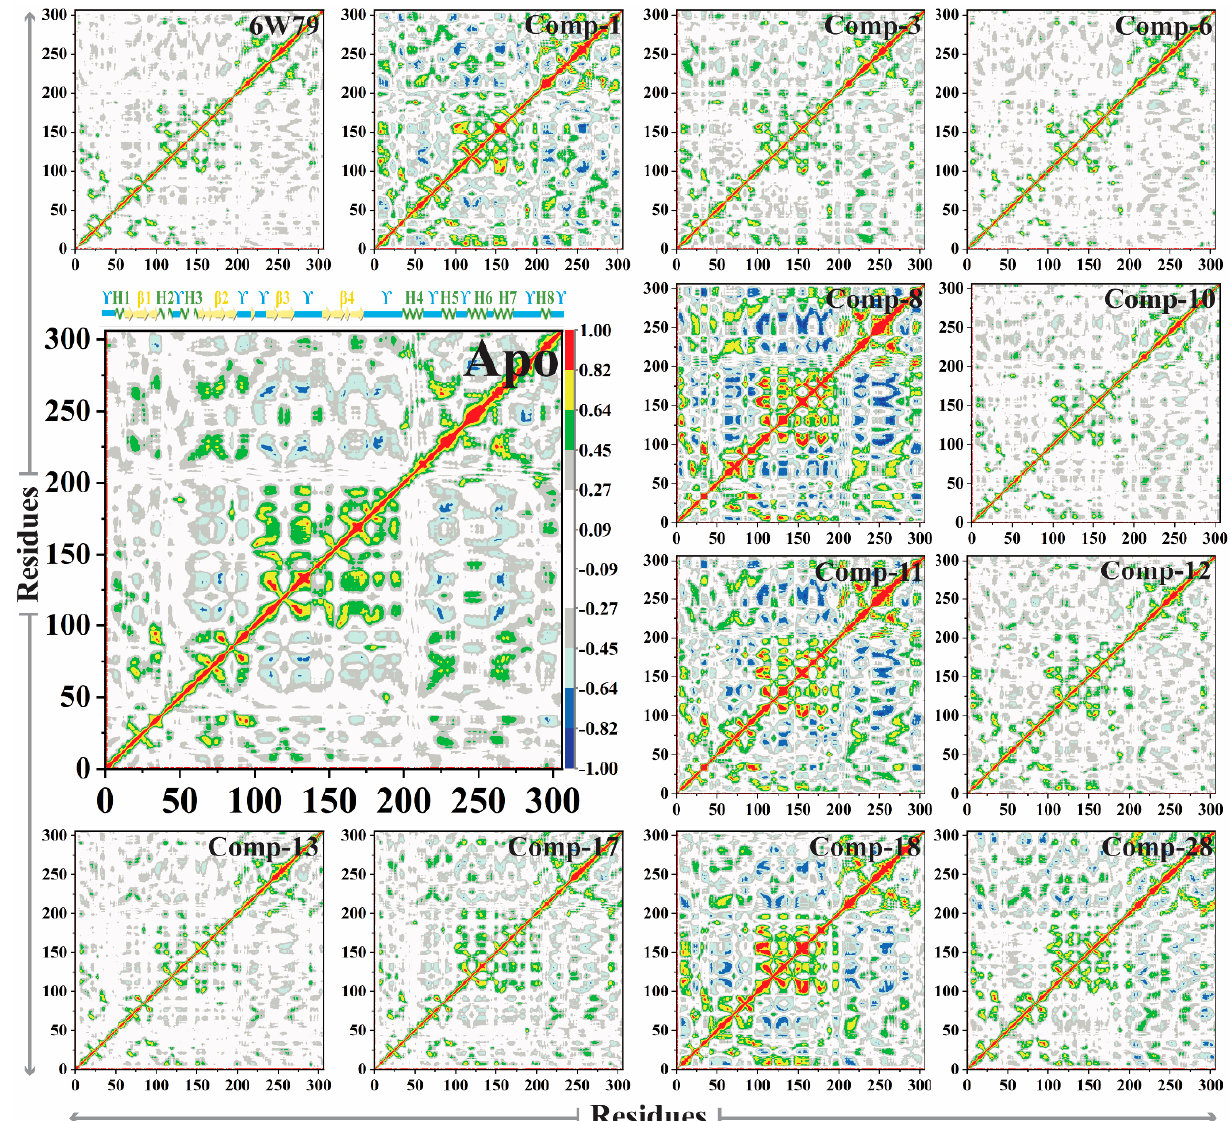
Figure 8. The DCCM plot of apo– and inhibited states of M pro is shown. The positive (green, yellow, and red) and the negative correlation motion (dark blue, light blue, and cyan) are shown in different colors. The incline in color (from one to another) indicates a slow decline in the correlation motion.